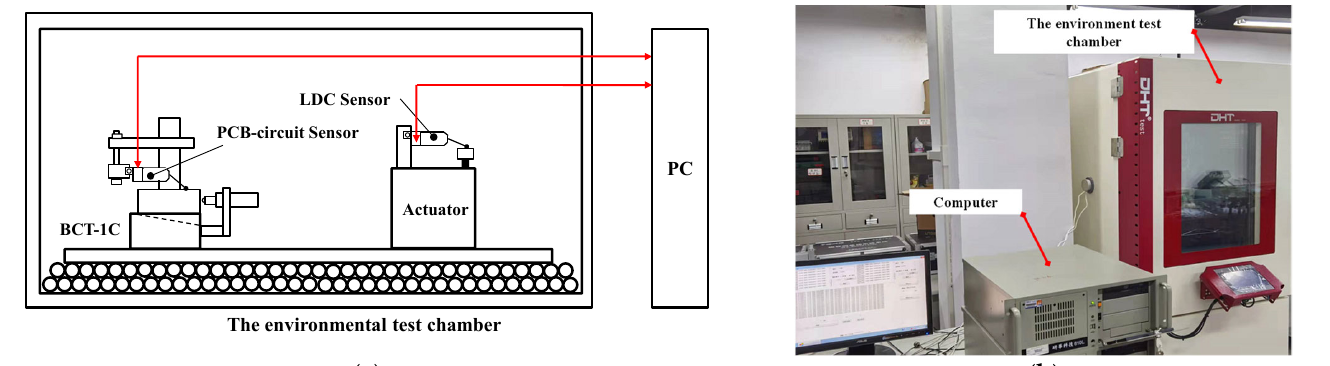
Figure 6. Experimental Section setup: ( a ) Experimental Section setup block diagram; ( b ) Picture of experiment setup.